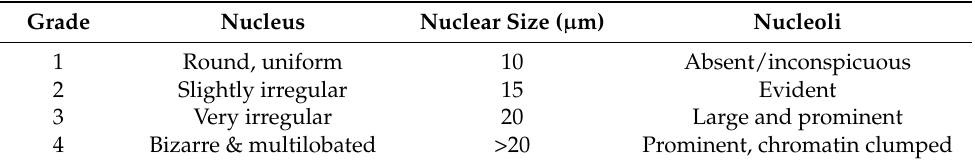
Table 6. Distant Metastasis (M) Stages in Renal Cell